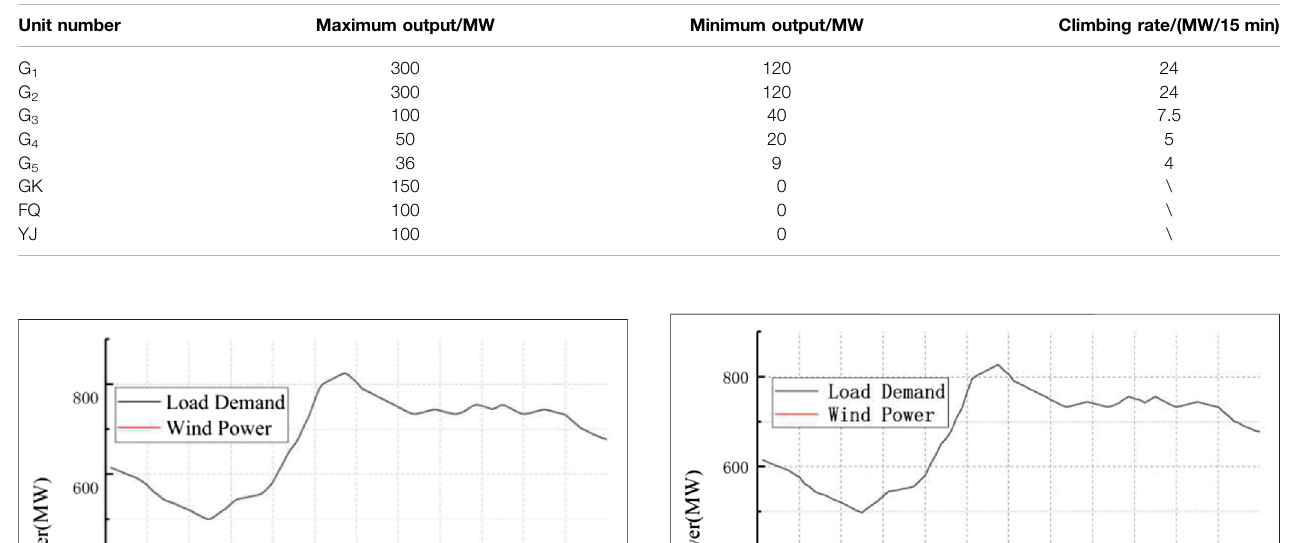
TABLE 1 | General parameters of generator set.